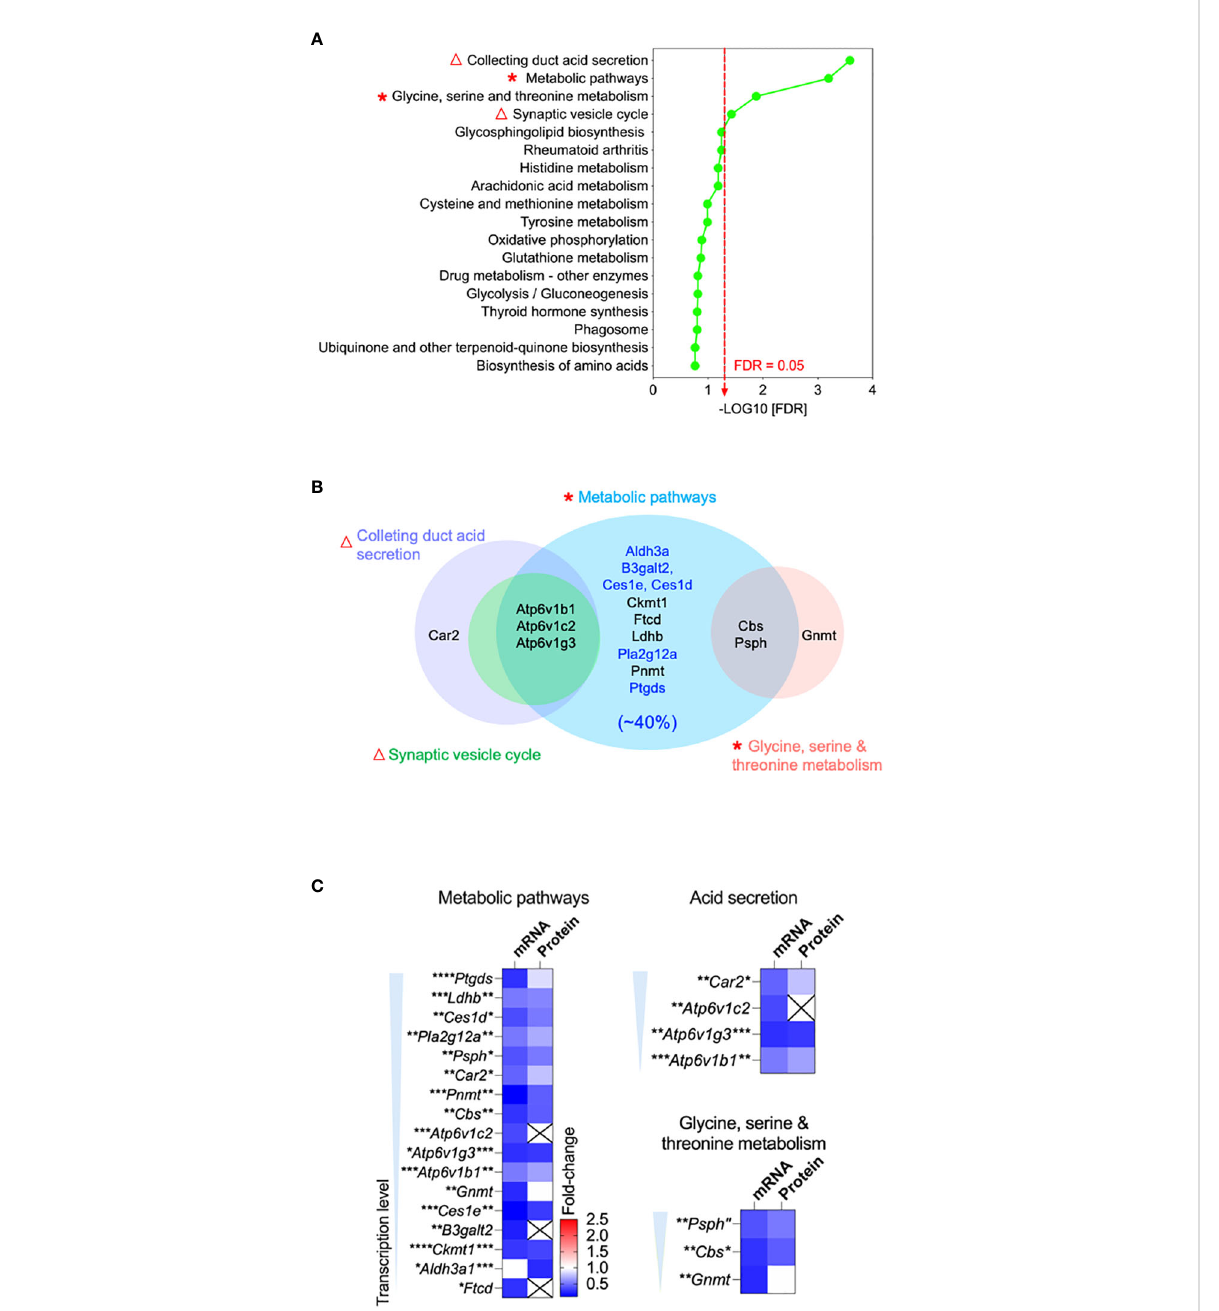
FIGURE 3 Bioinformatics revealed downregulation of acid secretion and metabolic pathways in the OCLN-de fi cient epididymis. (A) Integrative bioinformatic analysis revealed the downregulated acid secretion (triangles) and metabolic pathways (asterisks) in the epididymis of OCLN- de fi cient versus WT mice. Plot showing the enriched KEGG pathway terms obtained using all differential expressed genes (DEGs) of the combined transcriptomic and proteomics of whole epididymis of adult OCLN - de fi cient versus WT mice. Triangles indicate the impaired acid secretion associated pathways and asterisks metabolic associated pathways. (B) Venn diagram of the shortlisted DEGs in the signi fi cantly downregulated metabolic pathways in panel (A) Blue terms indicate the enriched genes for the enzymes relating lipid catabolism pathway, which makes up 40% of the shortlisted genes. (C) Heatmaps showing the fold-changes of transcriptional and proteomic levels of the shortlisted DEGs in the signi fi cantly altered pathways, including metabolism, acid secretion and amino acid metabolism. Data were means ± SD from (n > 3 animals per group). * P <0.05, ** P <0.01, *** P <0.001, **** P <0.0001, unpaired